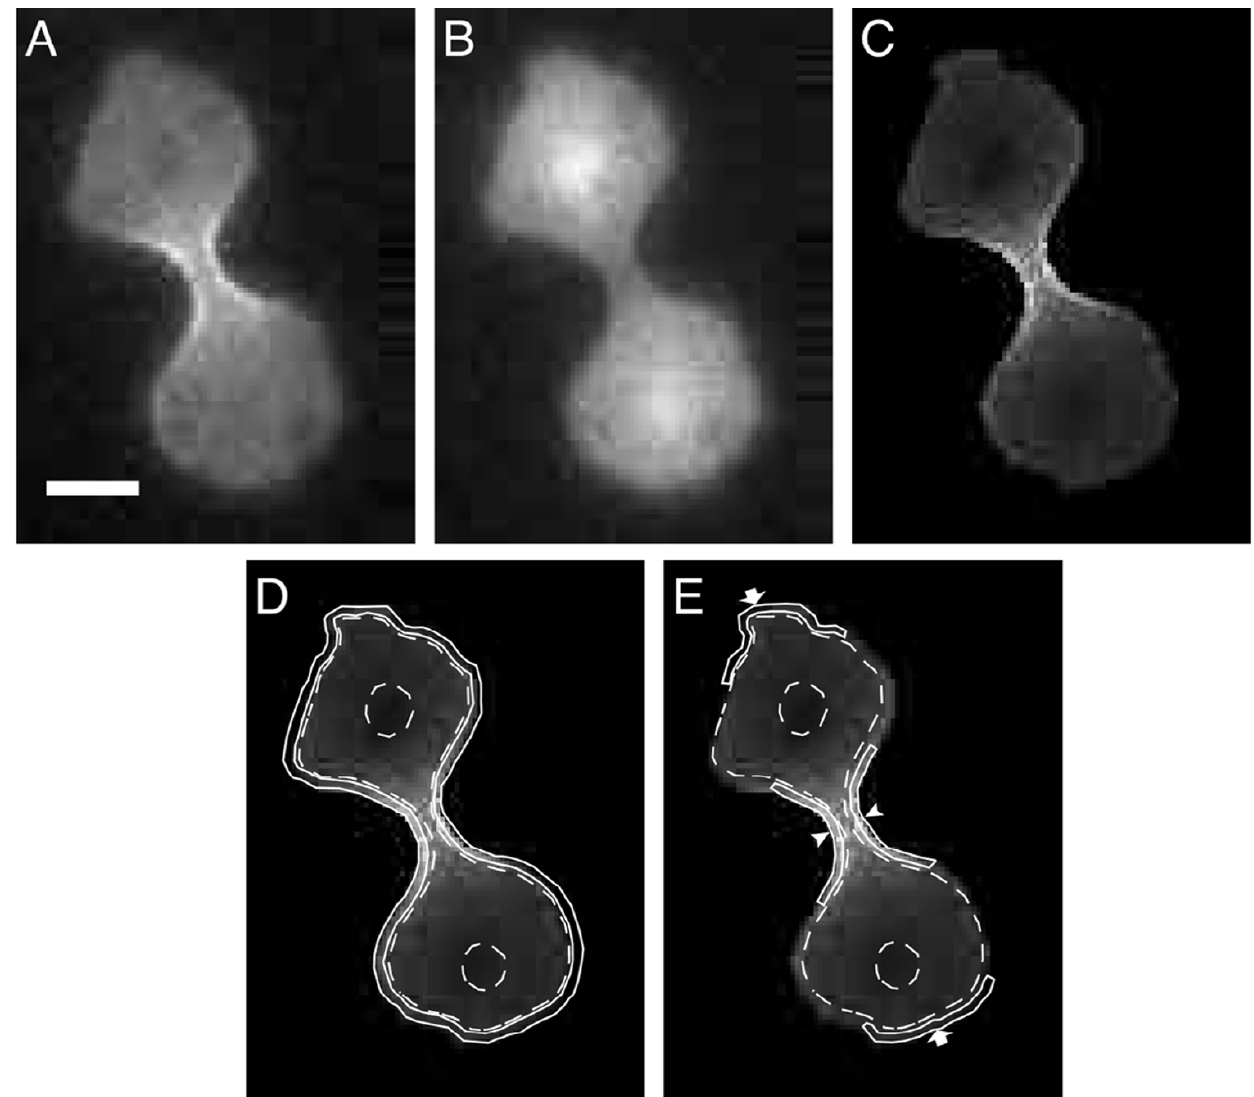
Figure 1 Regions defined for analysis. A. A dividing cell is imaged with excitation at 490 nm, showing GFP-myosin-II distribution. B . The same cell is imaged with excitation at 405 nm, showing the volume marker, NLS-GFP (nuclear localization signal fused to GFP) distribution. C. Division of the image in A with the image in B leads to this resulting ratio image. D. The cortex is defined as the 0.35- µ m thick shell of the cell, bordered by the solid continuous lines. The cytoplasm (outlined by dashed lines) is the total volume of the cell minus the volume of the cortex. It should be noted that the fluorescence intensity of the cytoplasm in the central region of the cell included the overlying and underlying cortex. However, the contribution of these cortical compo- nents to the total fluorescence intensity of the cytoplasmic region was calculated to be less than 2%. The nuclei are encircled to mark their positions, but their combined volume is inconsequential. E. The furrow cortex region is indicated with arrow- heads and the polar cortex is indicated with arrows. Bar, 5 µ